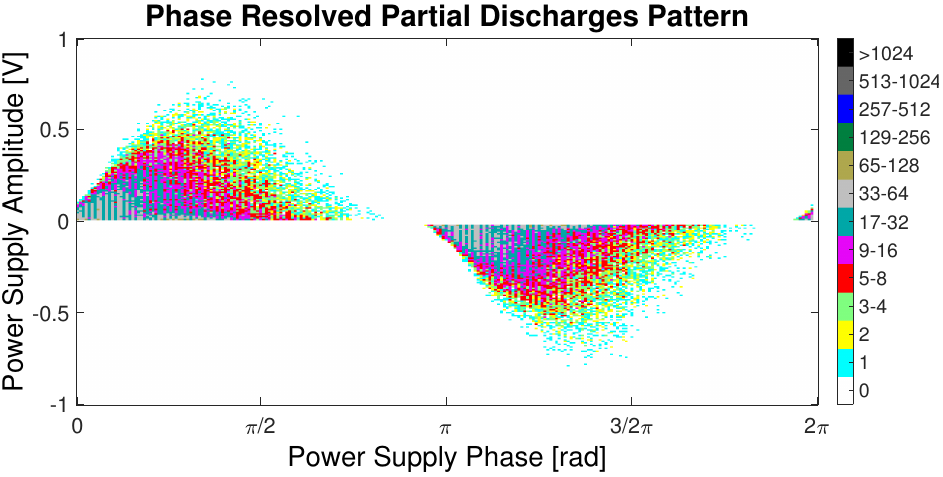
Figure 2. Phase resolved partial discharge pattern